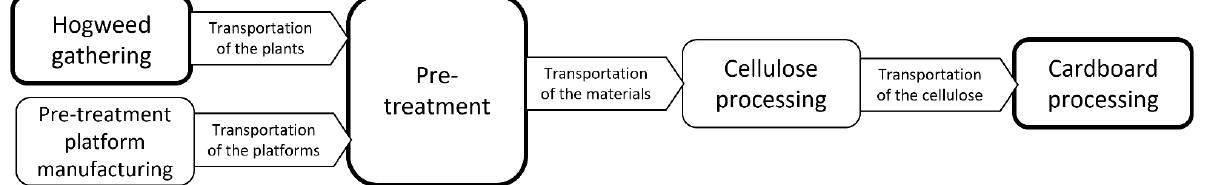
Figure 6. Business model ‘installations with pretreatment’. Bold contour highlights processes performed by other organizations (contractors, consumers, etc).